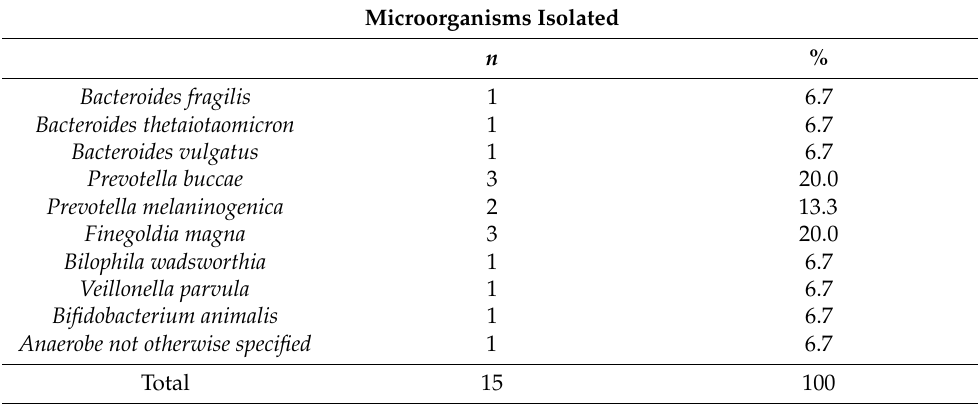
Figure 1. The CT scans of a patient that suffered from post-hepatectomy bilioma (white asterisk) originating from the remnant liver (RL). The left half of the image shows frontal/coronal plain, and the right half of the image shows the transverse plain. Table 3. The isolated bacterial strains.